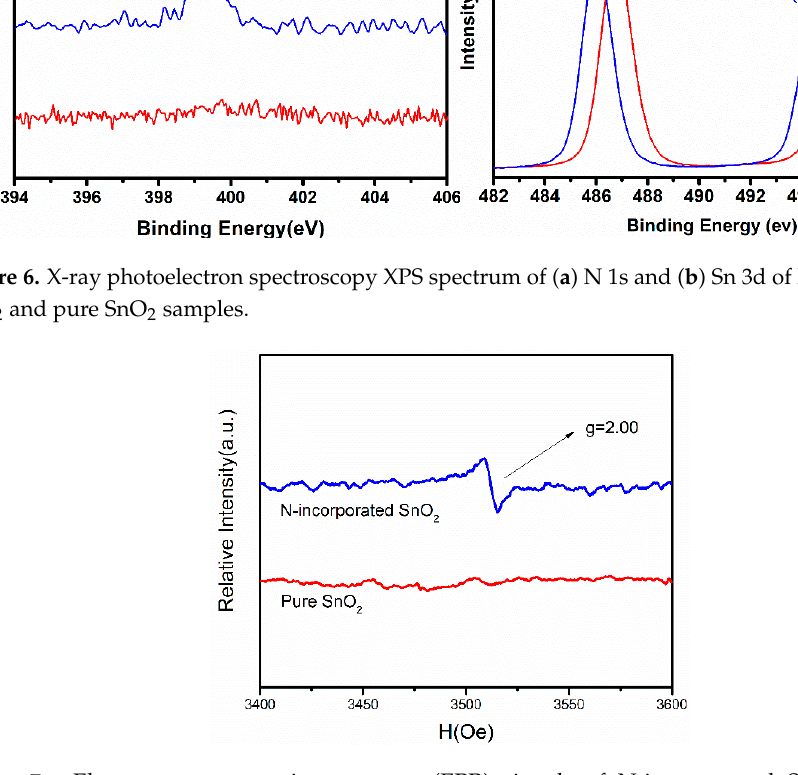
Figure 6. X-ray photoelectron spectroscopy XPS spectrum of ( a ) N 1s and ( b ) Sn 3d of N-incorporated SnO 2 and pure SnO 2 samples.